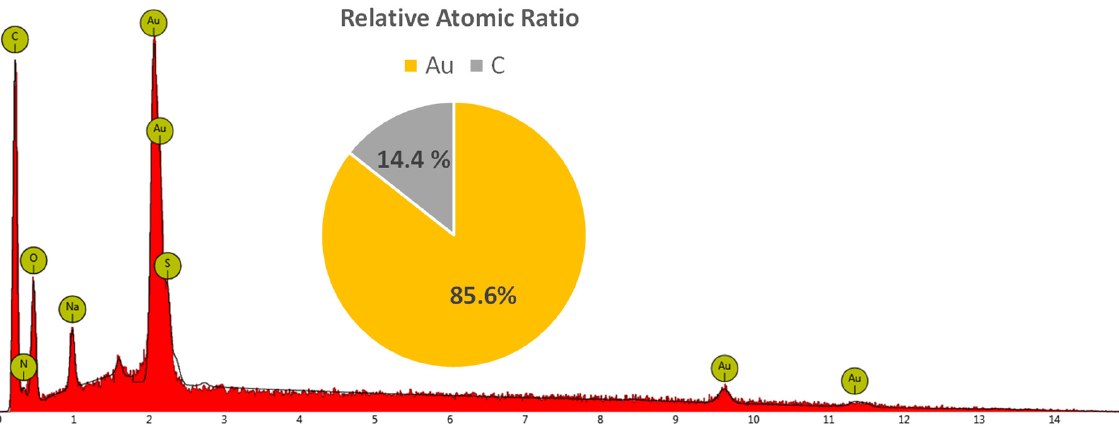
Figure 4. Elemental analysis and relative atomic abundance ratio of gold and carbon on AuNRs-C 12 .